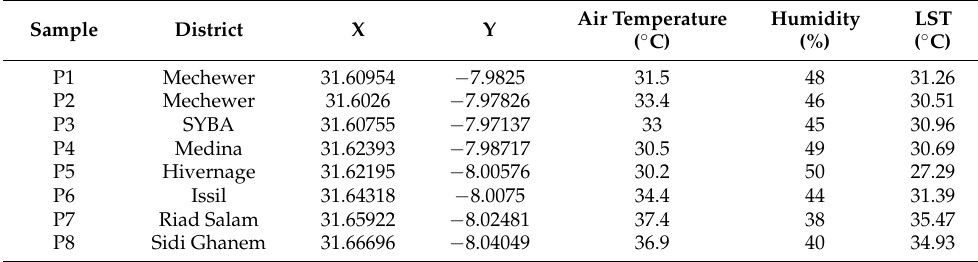
Table 1. Air temperature and humidity sampling